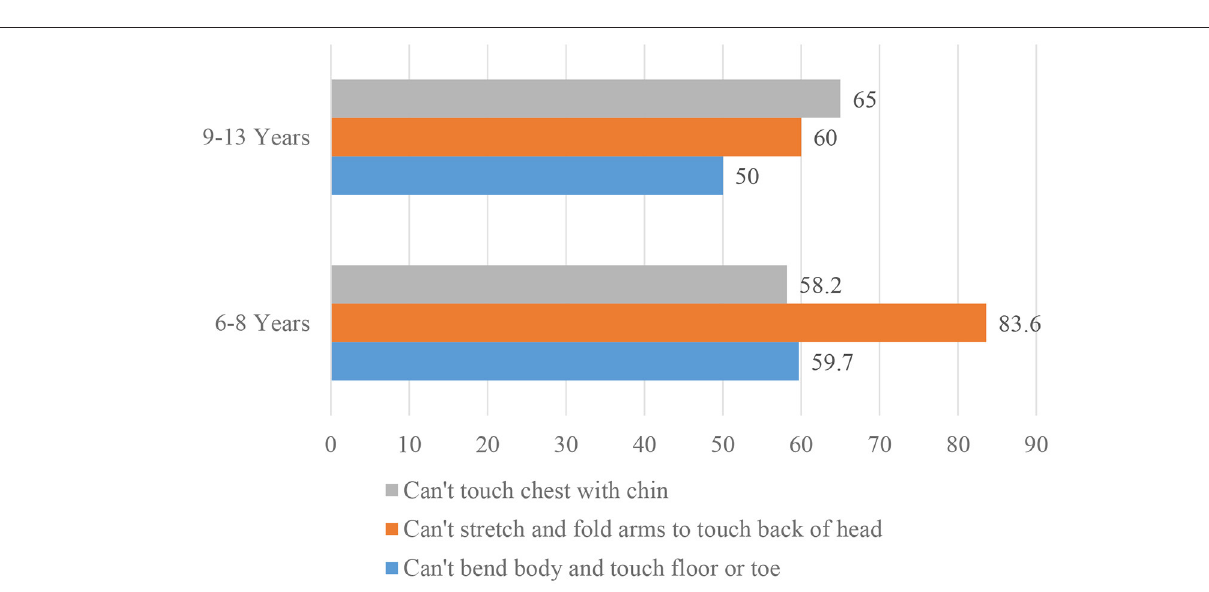
FIGURE 3 | Prevalence (%) of skeletal fluorosis (SK) among school children ( N = 127) in Halaba, SNNPR Ethiopia, 2019. The tests for SK are: SF Test-1 is “can’t bend body touch floor or toe”; SF Test-2 is “can’t stretch and fold arms to touchback of the head”; SF Test-3 “can’t touch the chest with the